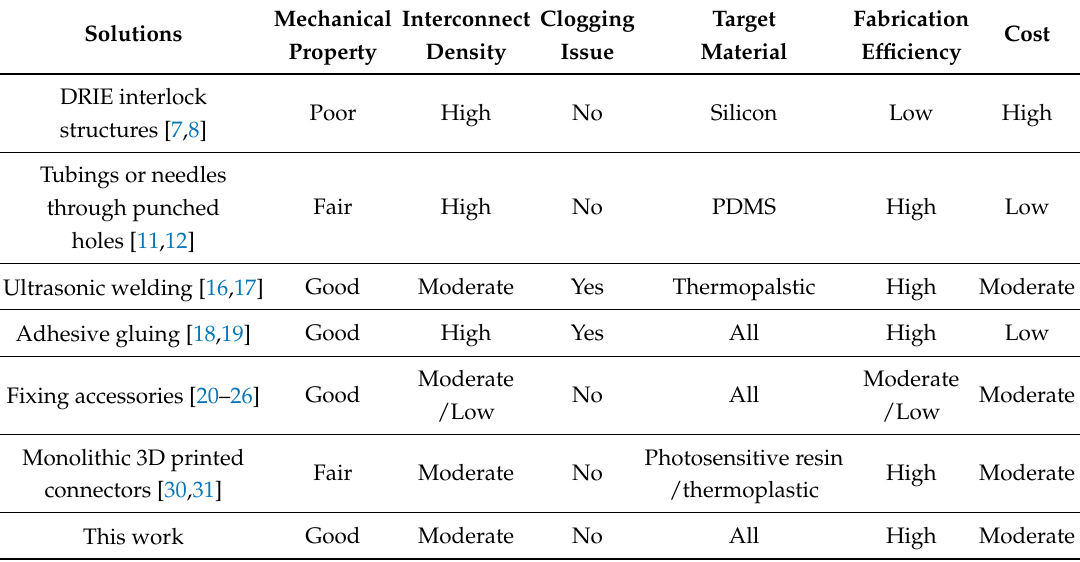
Table 1. Comparison of microfluidic interface